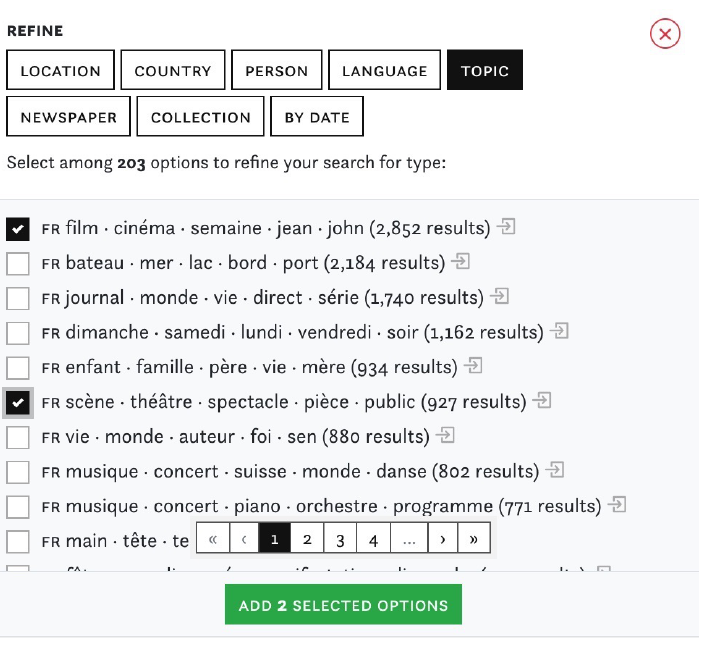
Figure 2. “Refine” view to add additional filters to queries and